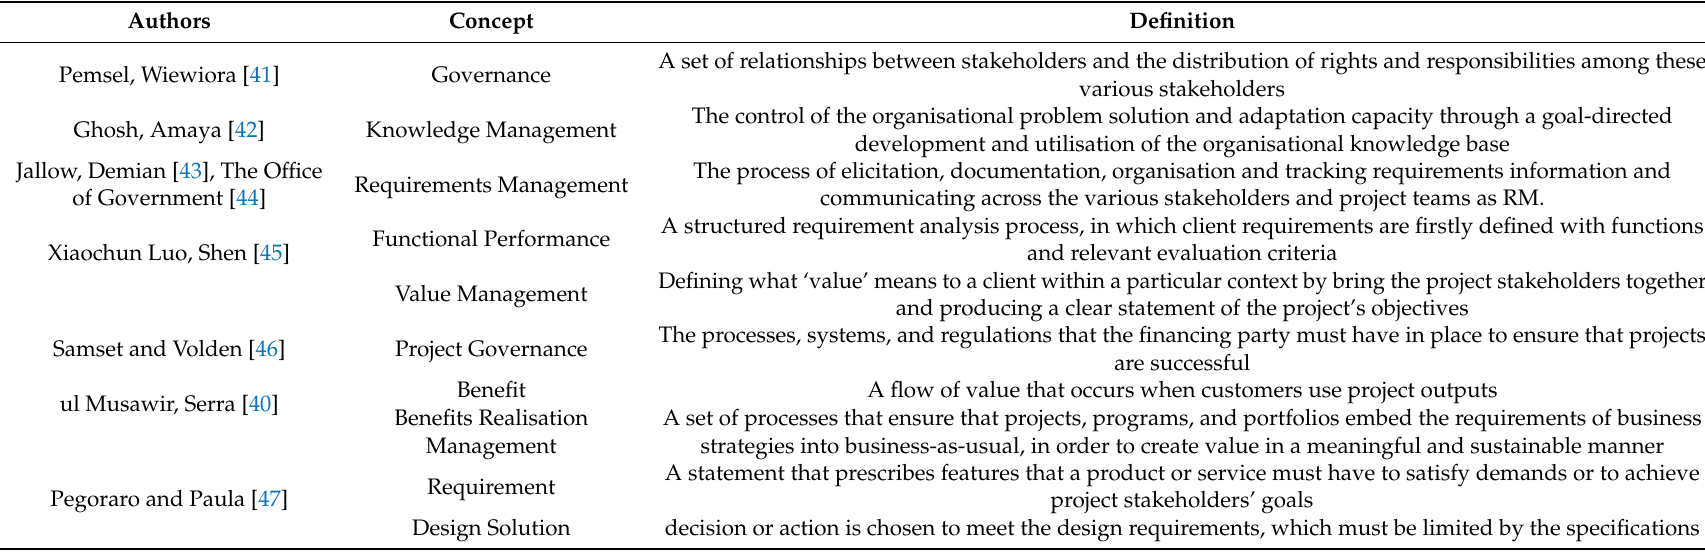
Table 2. Summary of definitions of key